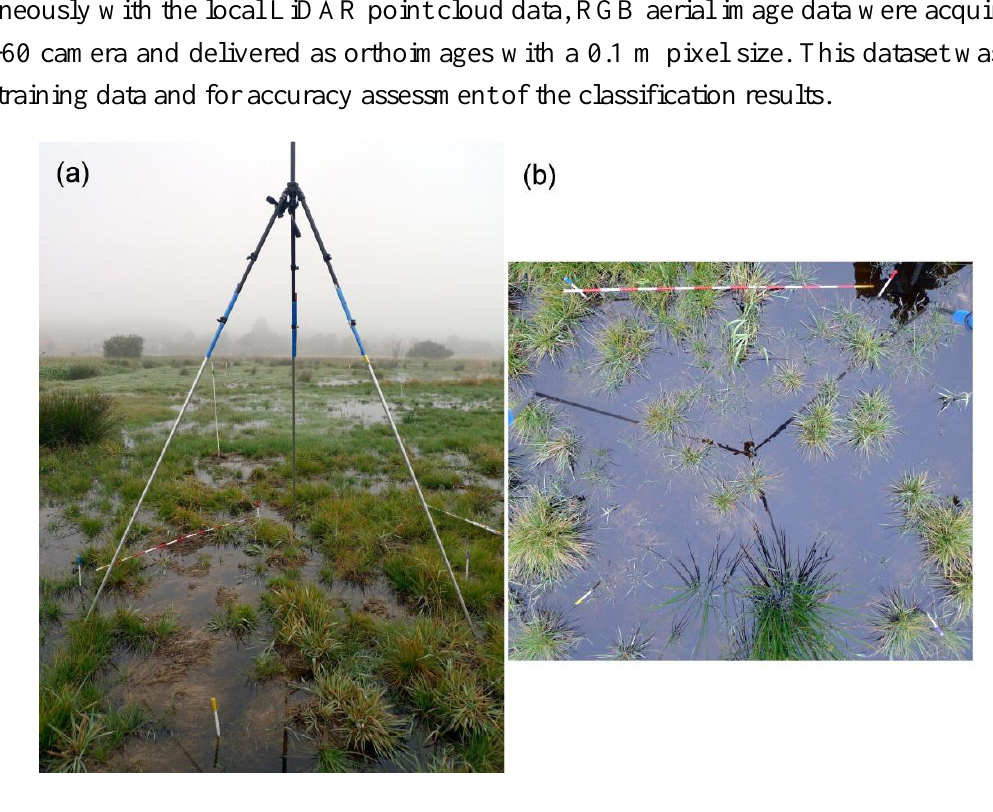
Figure 3. Example of a vertical image taken from a tripod used for collecting training data of the flooded classes: ( a ) tripod in a location with emergent grass and patches of water; ( b ) vertical image. Four white sticks with colored endings used for georeferencing vertical images are seen on both